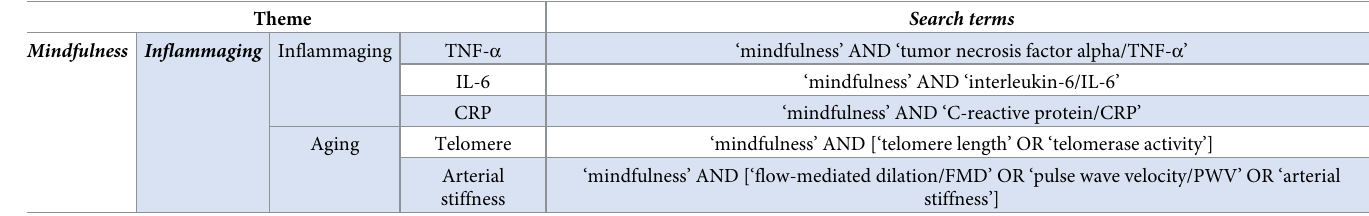
Table 1. The search